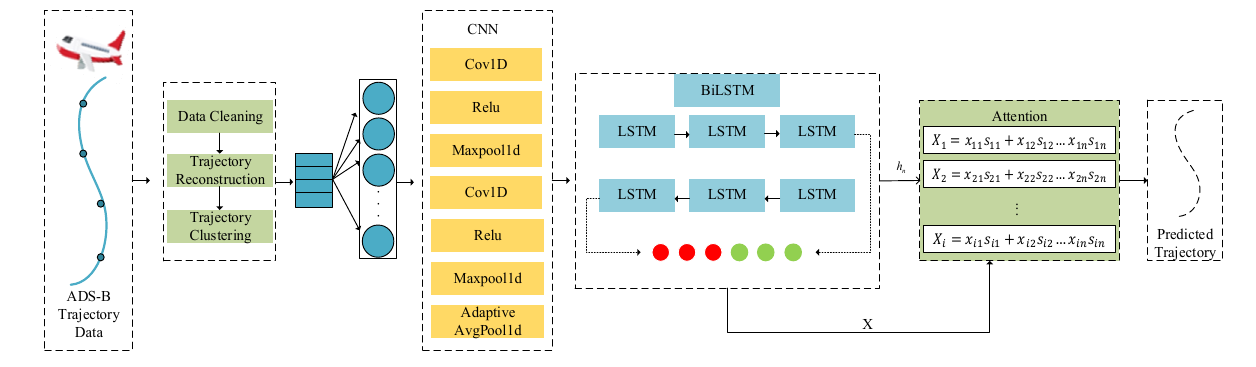
Figure 12. Model framework.